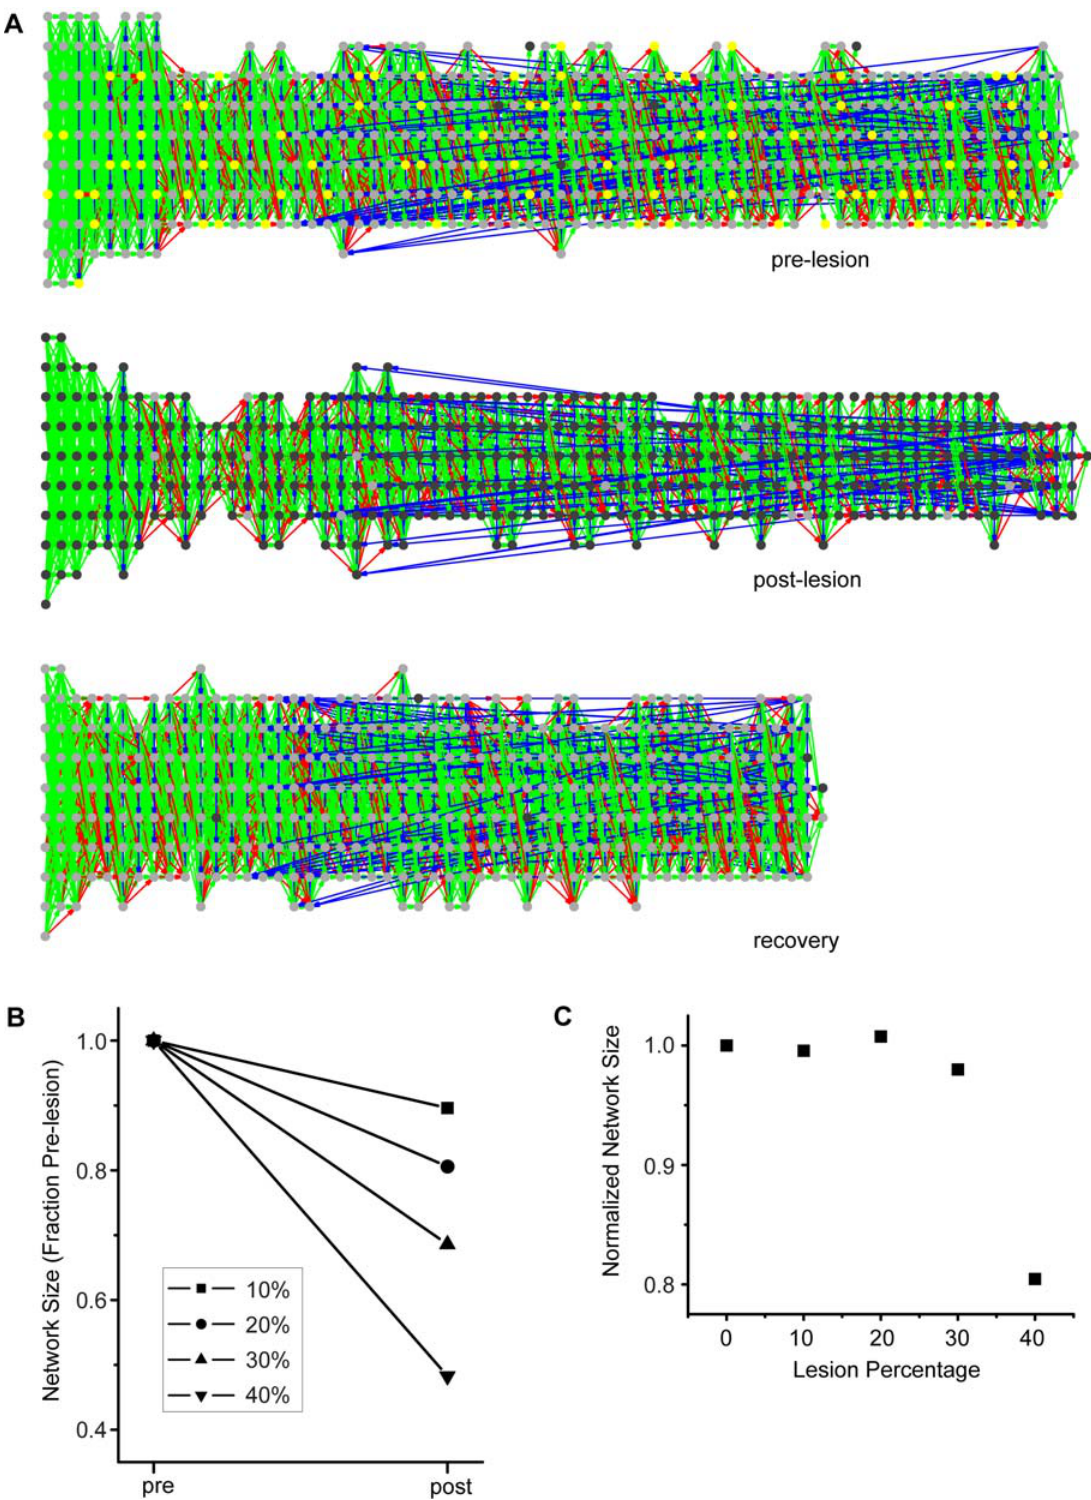
Figure 10. Network recovery from a mass lesion. (A) The maturenetwork of Figure 4 (upper) was given a 20% lesion (middle). The formation process was then allowedtoproceedasnormal, withnofurther neuronaldeath.The network was ablerecoverafter 100000trials(lower); it, however,endedupshorter and wider than normal. (B) Four different simulations using the same base network, but performing different levels of lesions at 10, 20, 30, and 40 percent. The plot shows the change in size of the chain, as defined by the number of neurons spiking reliably, from pre-lesion to post-lesion recovery. The chain does not recover to its normal size; it is shortened. (C) The size of the post-recovery network normalized by the number of neurons left intact directly after the lesion. The normalized size is close to 1 for lesions less than 40%, indicating that neurons are not added nor lost during the recovery. At forty percent however, the normalized size dips below 1, indicating that additional neurons are lost during the recovery period.